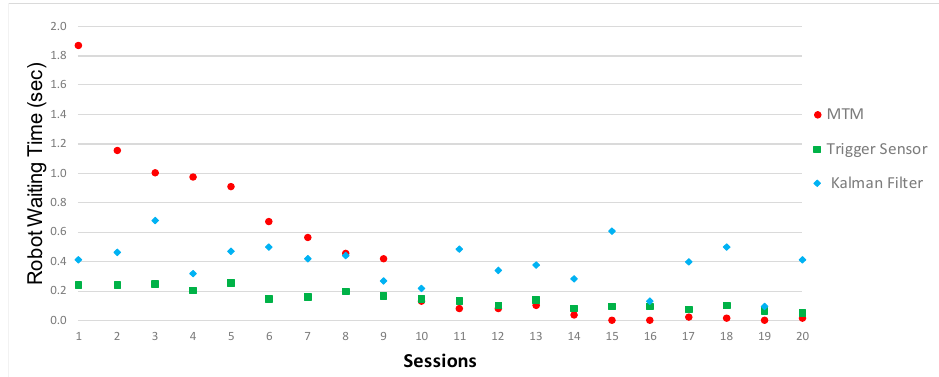
Figure 12. Time variation of the RWT for different handover prediction models under the assembly learning effect.